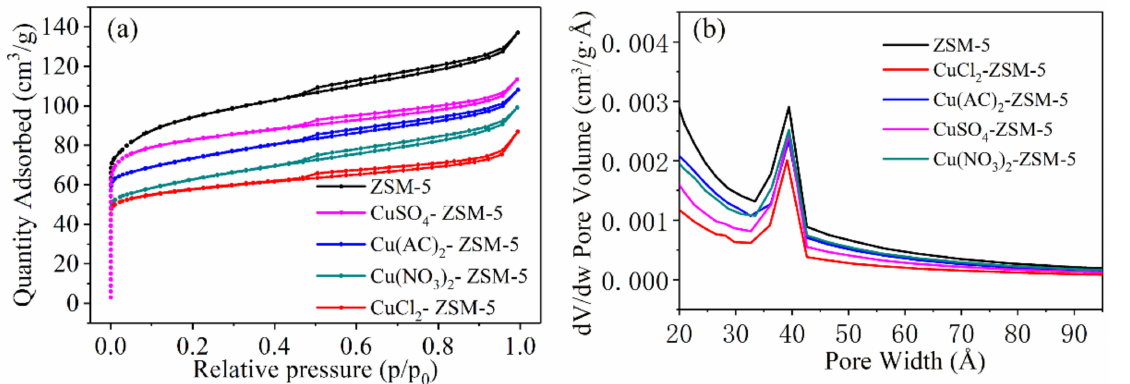
Figure 3. ( a ) Nitrogen adsorption and desorption curves of ZSM-5, 2.5% CuCl 2 -ZSM-5, 1.5% Cu(AC) 2 - ZSM-5, 2.5% CuSO 4 -ZSM-5, and 4.0% Cu(NO 3 ) 2 -ZSM-5, as well as their ( b ) aperture distribution